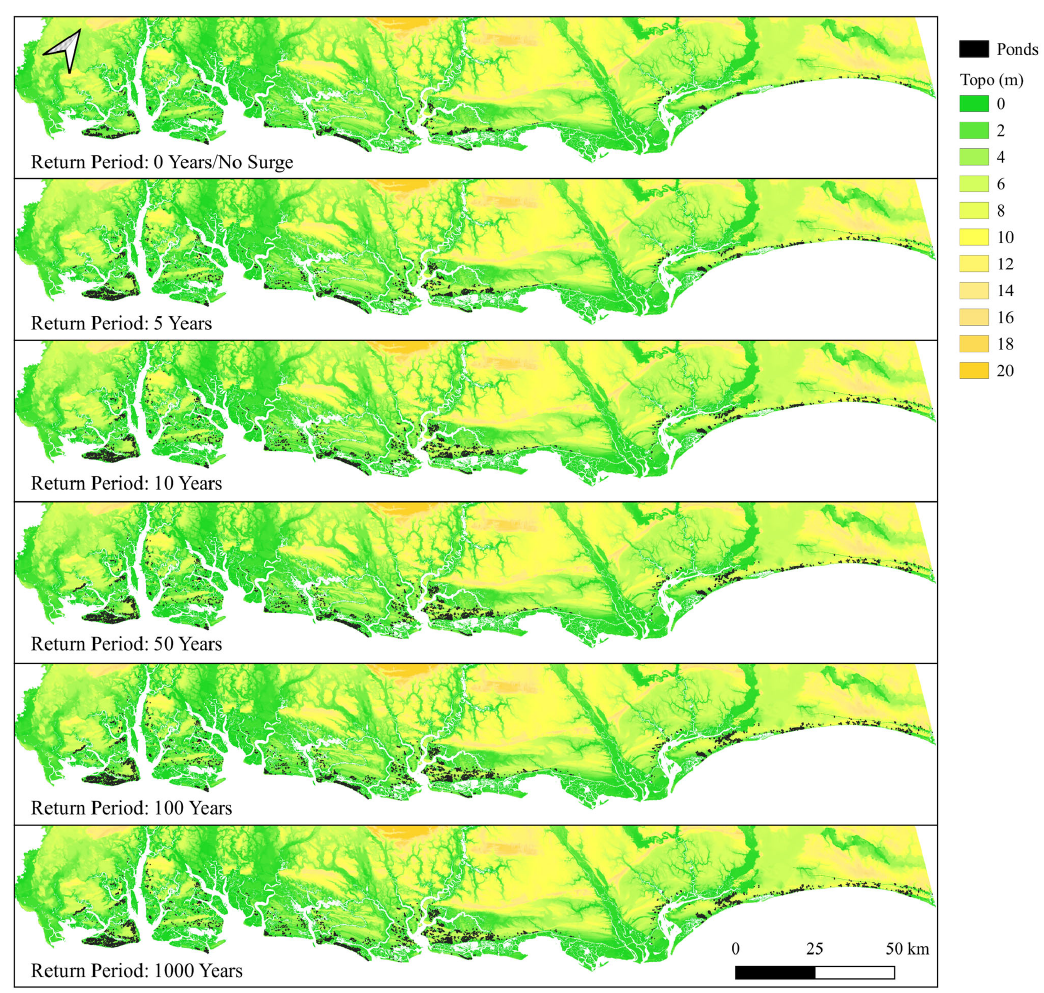
Figure 12. Map of SMPs at risk of storm surges for all of South Carolina, with different return periods under an SLR scenario of 2.0 m. The SMPs at risk are shaded black.